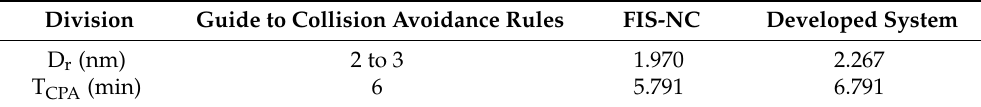
Table 6. Comparison of results of point positioning and timing for collision avoidance. Division Guide to Collision Avoidance